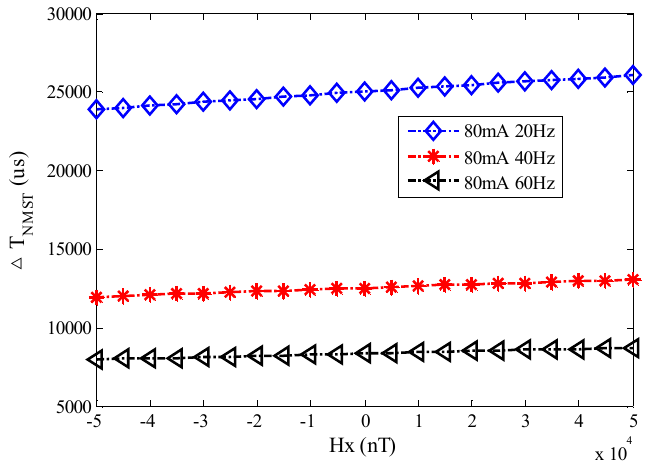
Figure 12. The curve between H x and Δ T NMST with different excitation frequencies.